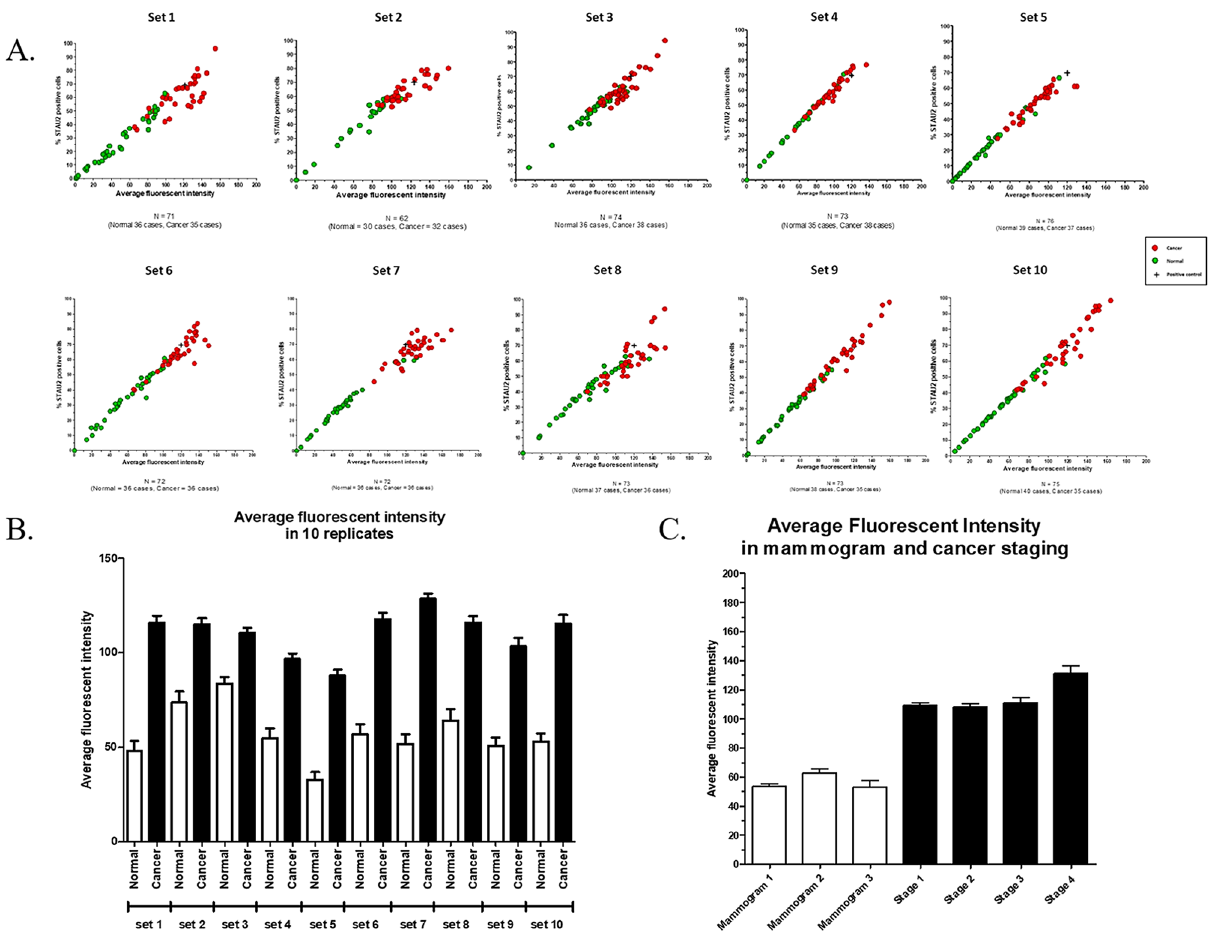
Figure 4. The results of the STAU2 fluorescent signal are presented as the average fluorescence intensity and the percentage of positive cells. ( A ) The replicative test of STAU2 staining, which was performed with a double- blinded test including 10 replicates (sets 1 (N = 71), 2 (N = 62), 3 (N = 74), 4 (N = 73), 5 (N = 76), 6 (N = 72), 7 (N = 72), 8 (N = 73), 9 (N = 73), 10 (N = 75)). Positive samples from cocultured PBMCs were applied as interassay variation adjustments. The average fluorescence intensity and the percentage of STAU2-positive cells exhibited a linear correlation (R 2 > 0.9). ( B ) Increases in fluorescence intensity and the percentage of positive cells were observed in all replicates ( p < 0.0001). ( C ) The average fluorescence intensity was not significantly different among WBCs obtained from normal females with 1 to 3 mammograms, but an increasing trend was found from early-stage to late-stage breast cancer patients ( p = 0.0008). The intensity detection and the percentage of STAU2- positive cells were operated by CellSens imaging software (Olympus Co., Ltd.,